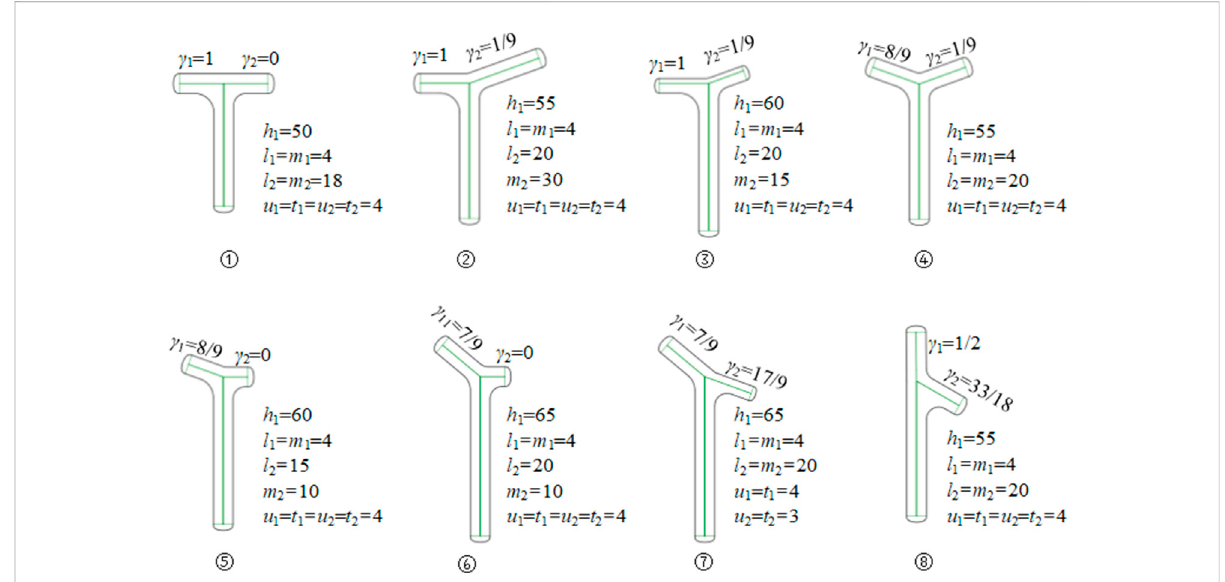
FIGURE 5 Bionic vein structure features of customized T-shaped plates. By modifying semantic parameters in Figure 2B, the adjacency matrices M 1 and